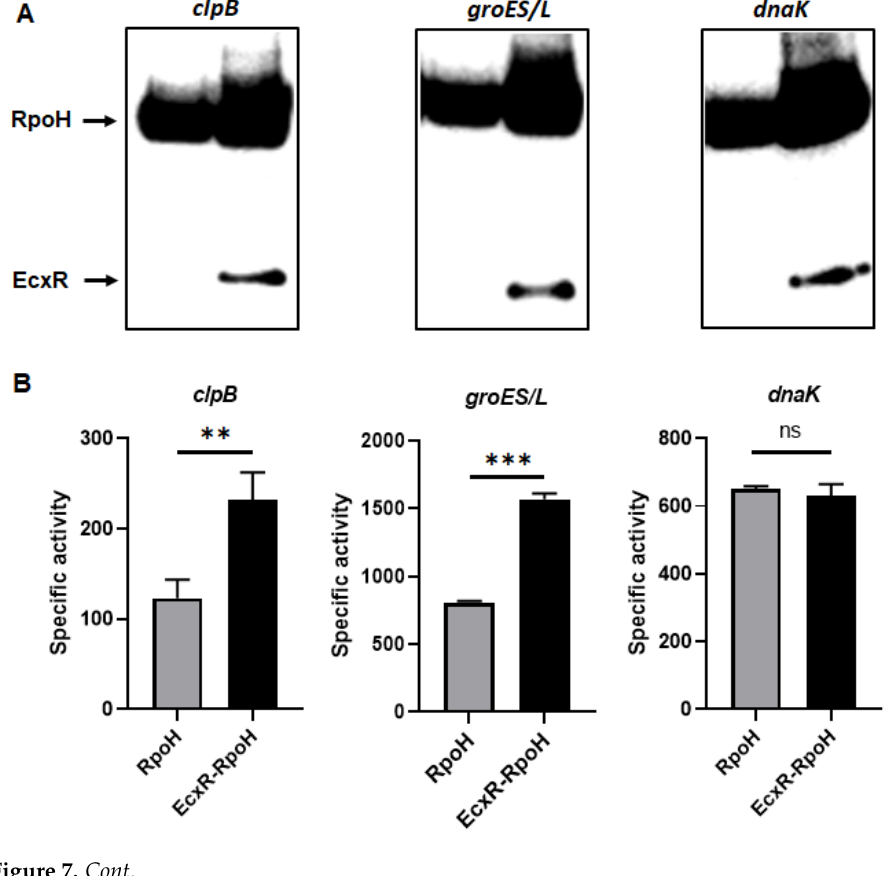
Figure 7. Assess the role of EcxR on the transcription of E. chaffeensis promoter-lacZ reporter con- structs. β -galactosidase assays were performed to measure the transcriptional activities of lacZ re- porter constructs. ( A , C ) Western blot analyses of samples from β - galactosidase assays were carried